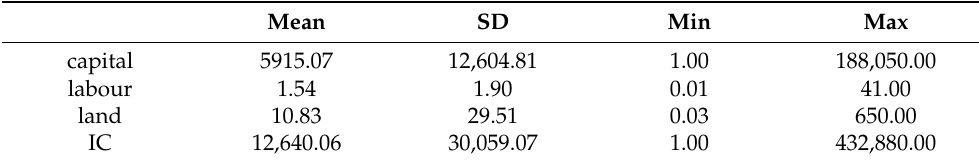
Table 3. Summary